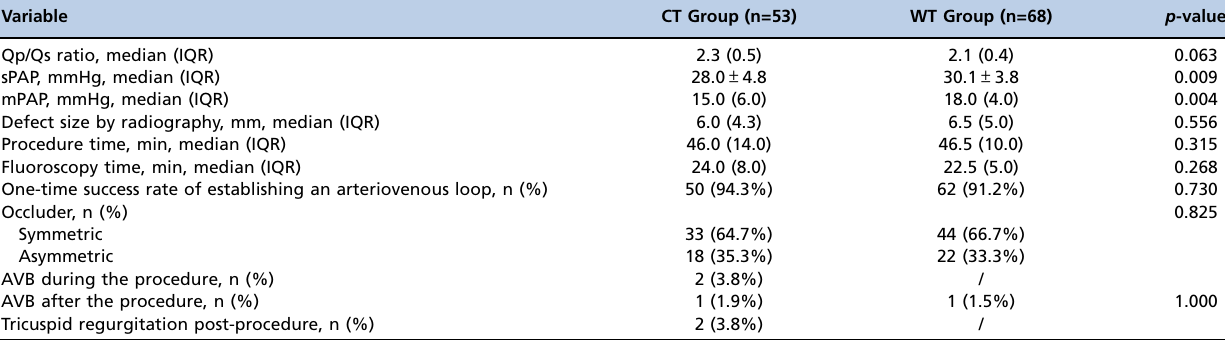
Table 2 - Procedural Characteristics of the Two Groups.